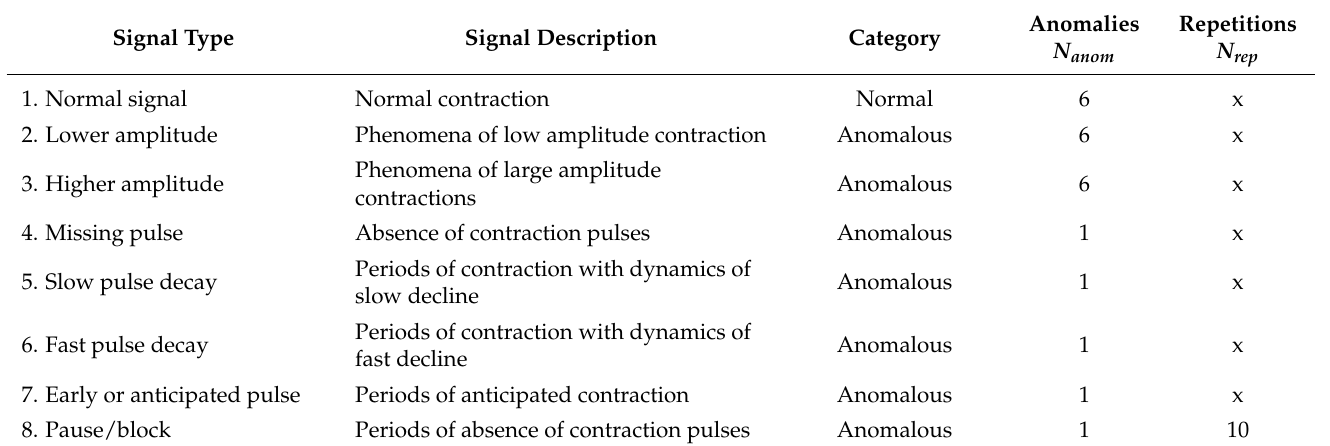
Table 3. Types of signals in the synthetic dataset. The x means not used parameter. Signal